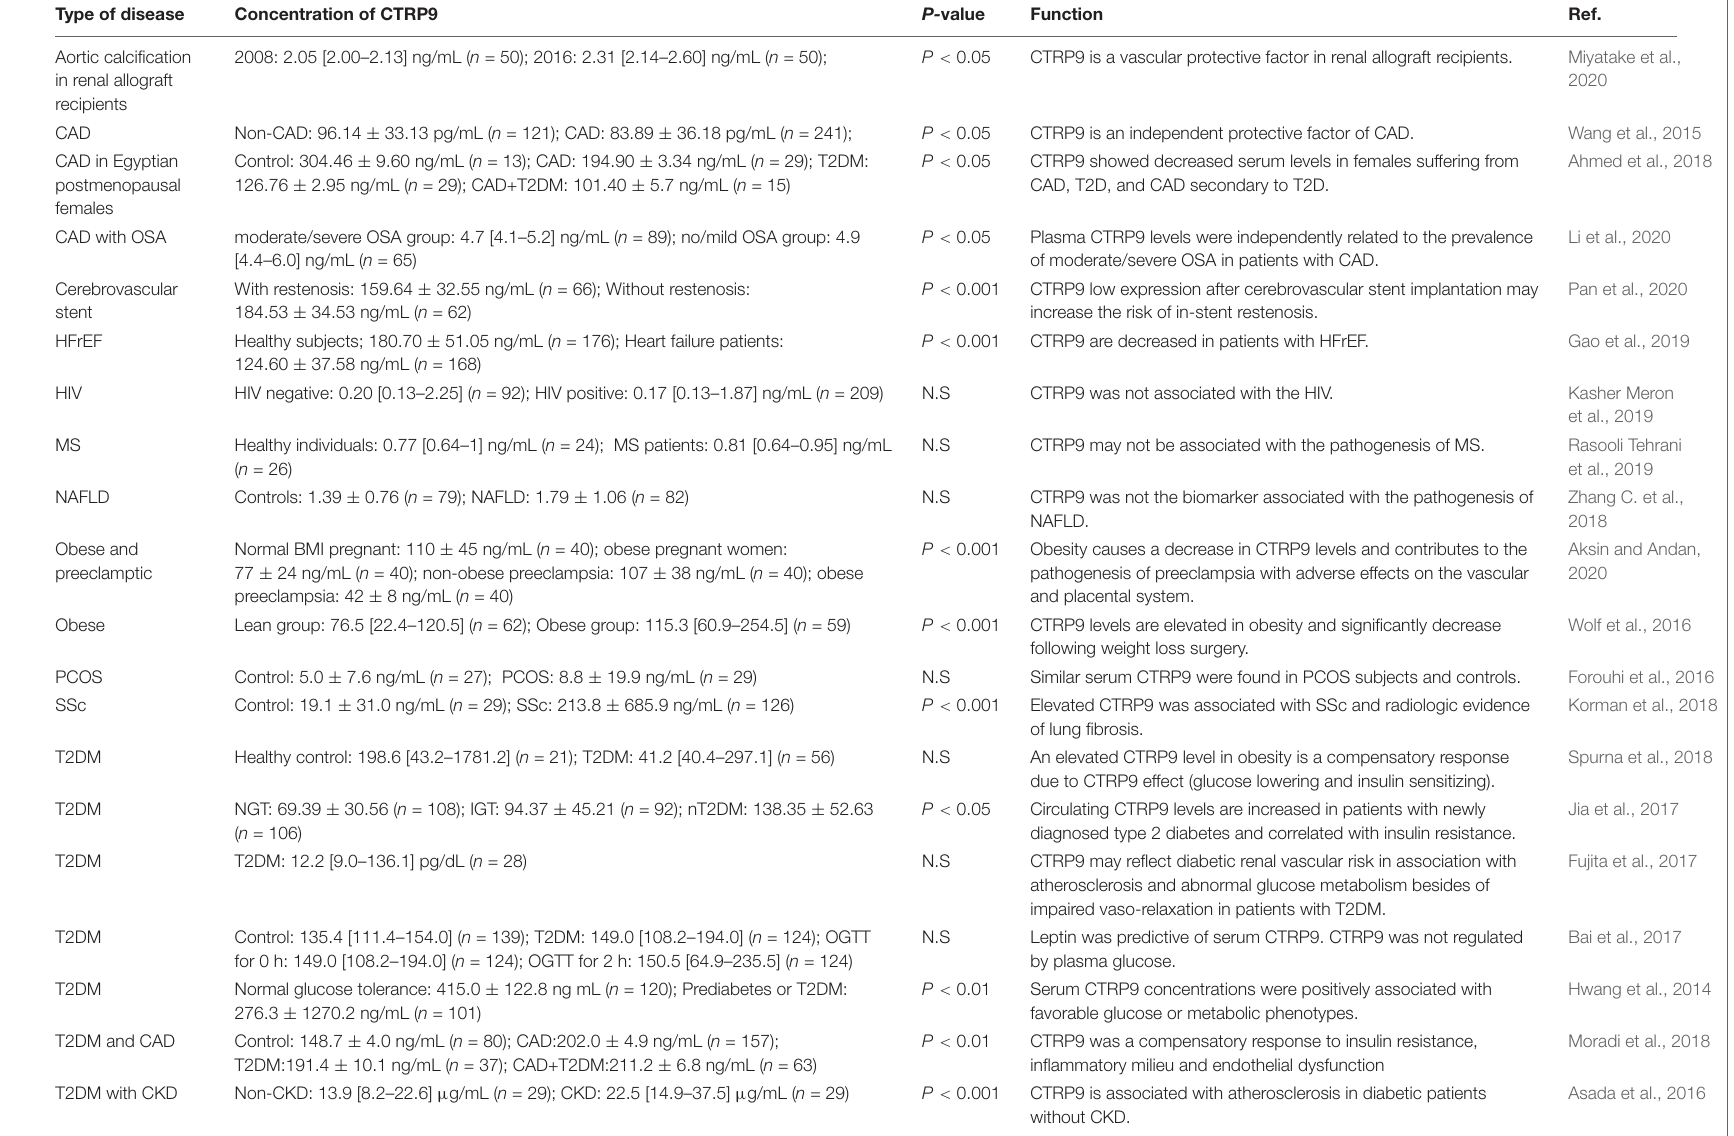
CAD, coronary heart disease; CKD, chronic kidney disease; HFrEF, heart failure with reduced ejection fraction; HIV, human immunodeficiency virus; MS, multiple sclerosis; NAFLD, nonalcoholic fatty liver disease; OSA, obstructive sleep apnea; PCOS, polycystic ovary syndrome; SSc, Systemic sclerosis; T2DM, type II diabetes mellitus; N.S,